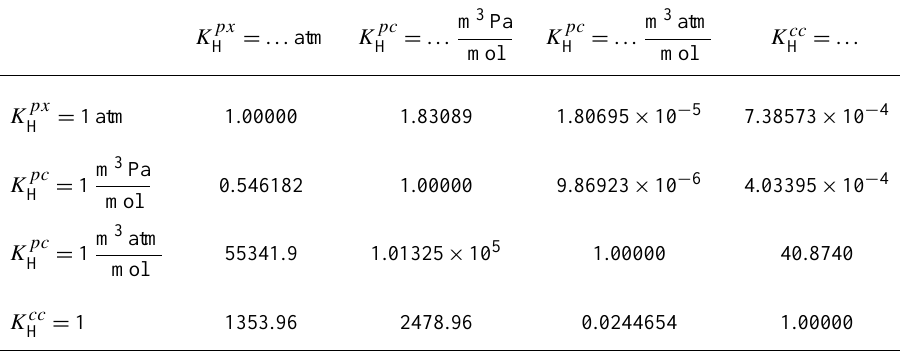
Table 2. Conversion factors between several Henry’s law volatility constants K H (at T (cid:9) = 298.15K and % (cid:9) = 997kg m − 3 ).